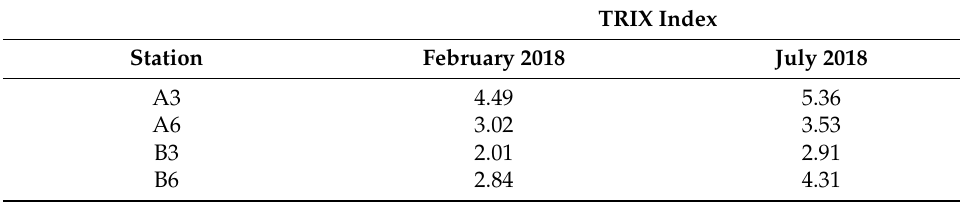
Table 4. TRIX index